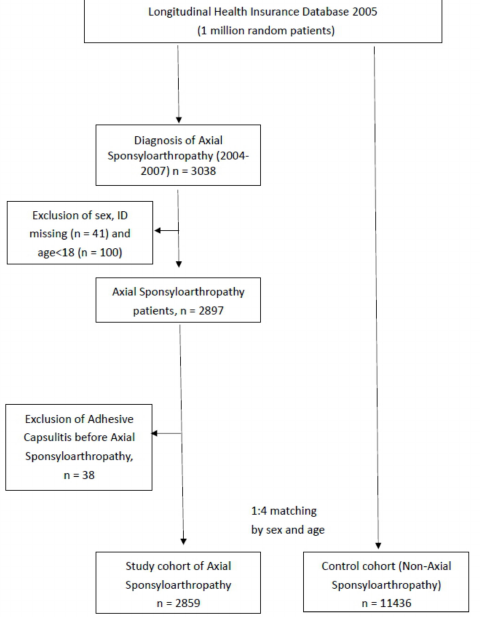
Figure 1. Flowchart showing the study